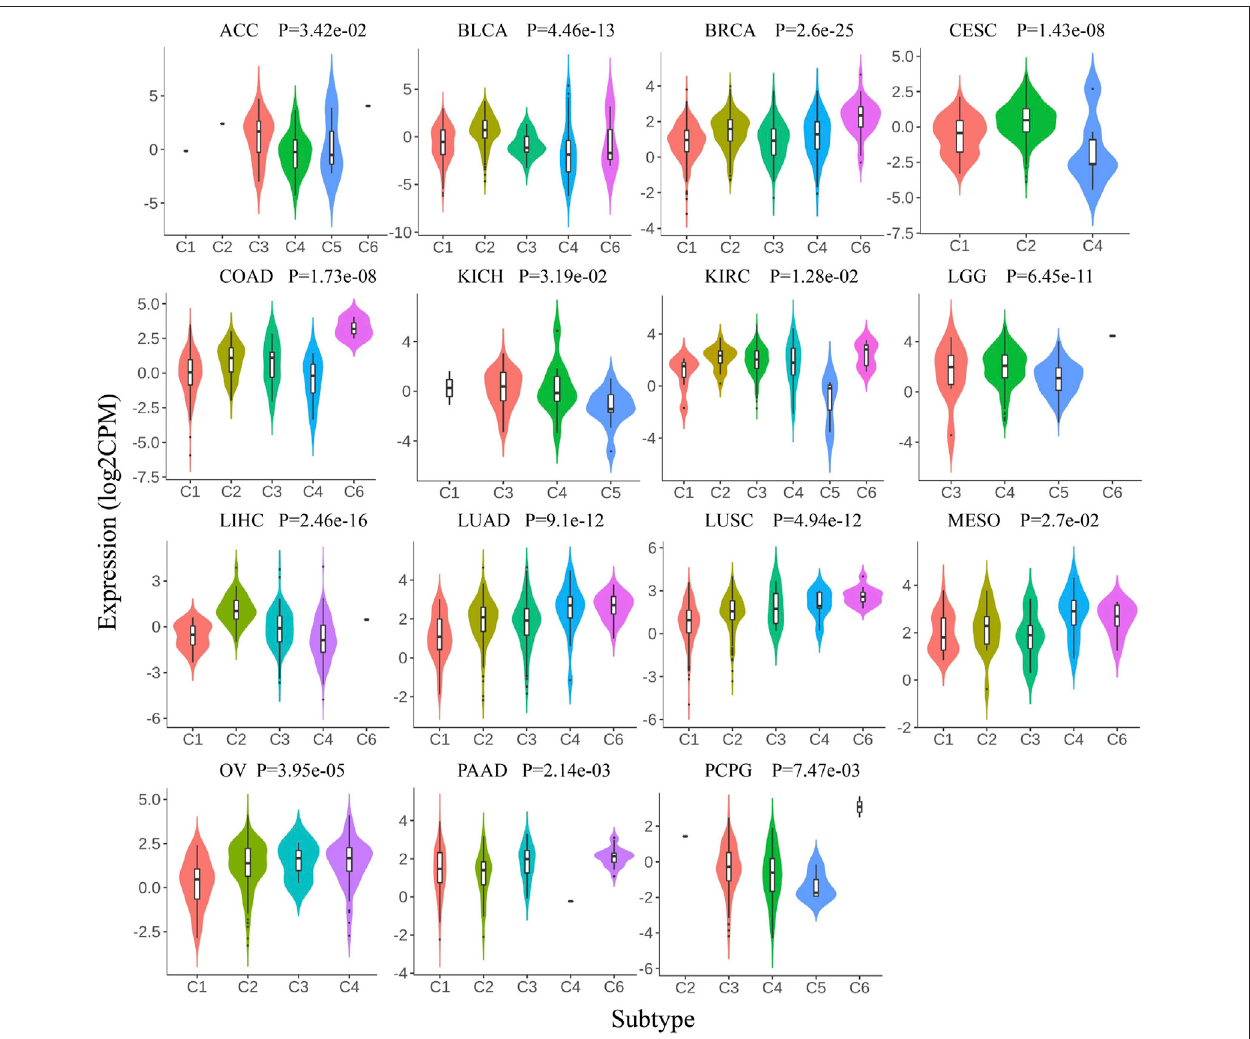
FIGURE4| CorrelationbetweenSiglec-9mRNAexpressionandtumorimmunesubtypesdependedonTISIDB.Siglec-9mRNAexpressionwasrelatedtoimmune subtypes in various cancers (top 15 tumors were shown). Immune subtypes included: C1, wound healing; C2, IFN- γ dominant; C3, in fl ammatory; C4, lymphocyte depletes; C5, immunologically quiet; and C6, TGF- β dominant. (Kruskal – Wallis test, p < 0.05 was considered to be signi fi cant. CPM: count-per-million.)